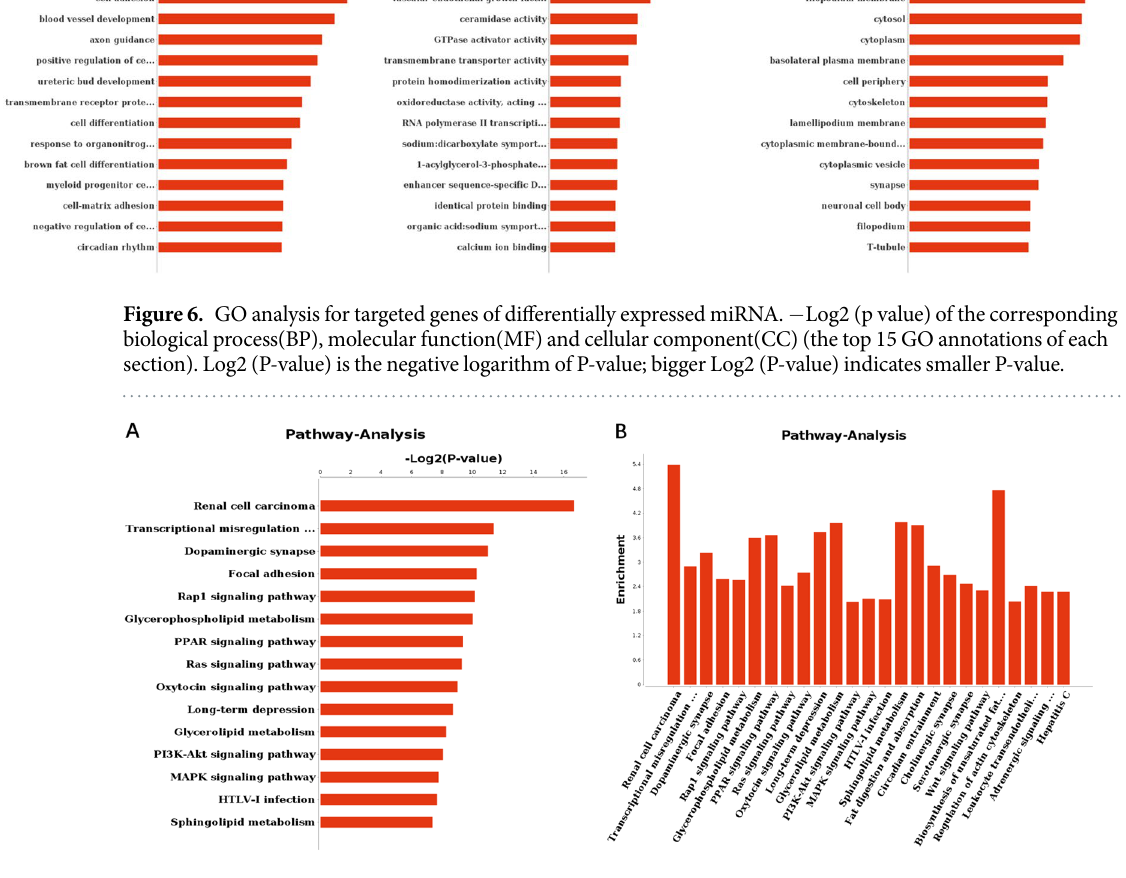
Figure 7. Pathway analysis for targeted genes of differentially expressed miRNA. − Log2 (p value) of the corresponding pathway ( A ). Enrichment for the top 25 selected pathway ( B ).